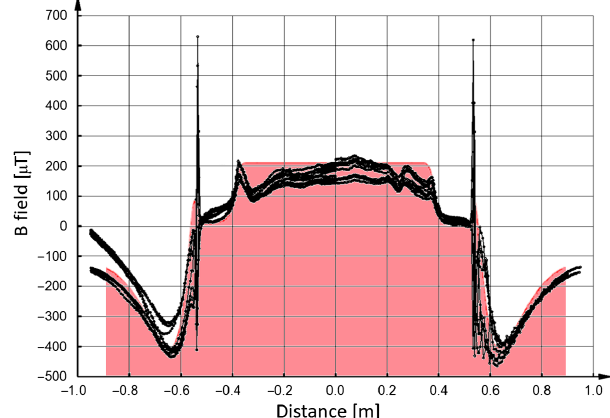
cycling.FIG. 14. Cross section of the septum magnet, with enlargement of the gap region. The upper half of the iron core with the coil winding is in air, and the lower half with beam apertures is in vacuum, with a 1-mm copper sheet as vacuum sealing. The aluminum support block for the thin copper sealing plate is